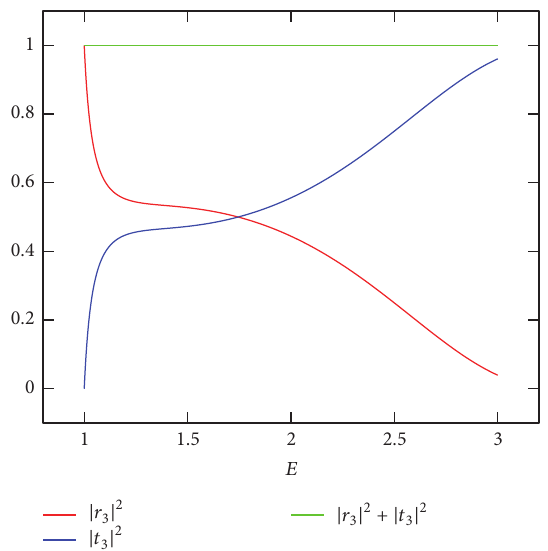
Figure 5: Plots of |𝑟 3 | 2 , |𝑡 3 | 2 , and |𝑟 3 | 2 + |𝑡 3 | 2 as energy